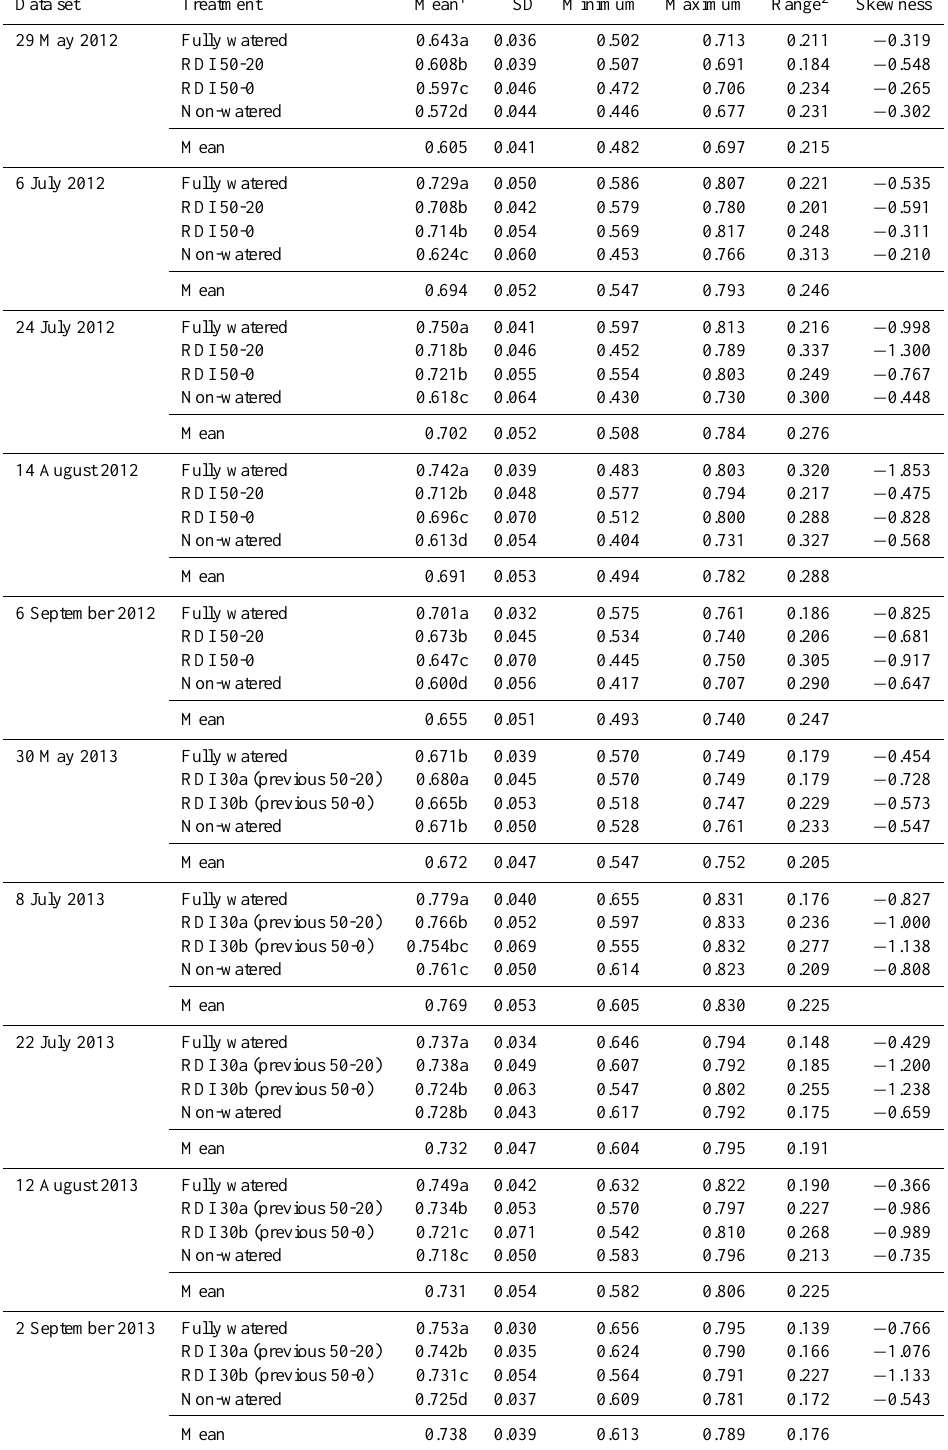
Table 6. Statistic descriptive analyses of the NDVI interpolated data sets for 2012 and 2013 growing seasons (dimensionless). Data